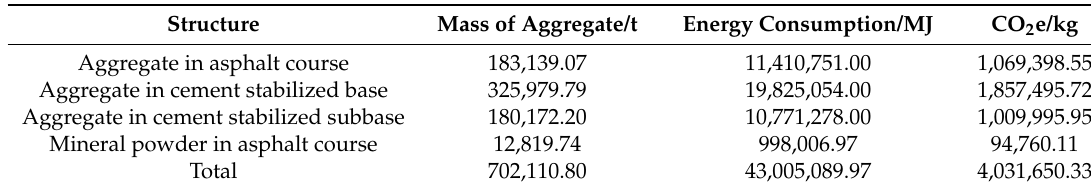
Table 2. GHG emissions of mineral aggregate